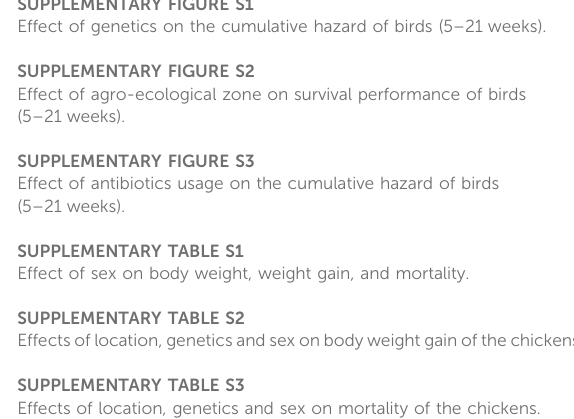
SUPPLEMENTARY FIGURE S2 Effect of agro-ecological zone on survival performance of birds (5 – 21 weeks). SUPPLEMENTARY FIGURE S3 Effect of antibiotics usage on the cumulative hazard of birds (5 – 21 weeks). SUPPLEMENTARY TABLE S1 Effect of sex on body weight, weight gain, and mortality. SUPPLEMENTARY TABLE S2 Effects oflocation,geneticsand sex on body weight gain ofthe chickens. SUPPLEMENTARY TABLE S3 Effects of location, genetics and sex on mortality of the chickens. SUPPLEMENTARY TABLE S4 Effect of antibiotics use on body weight, weight gain, and mortality of the